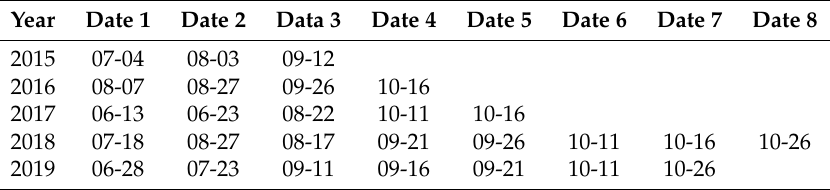
Table 3. Acquisition dates of Sentinel-2 data in the respective years of the observation period 2015–2019